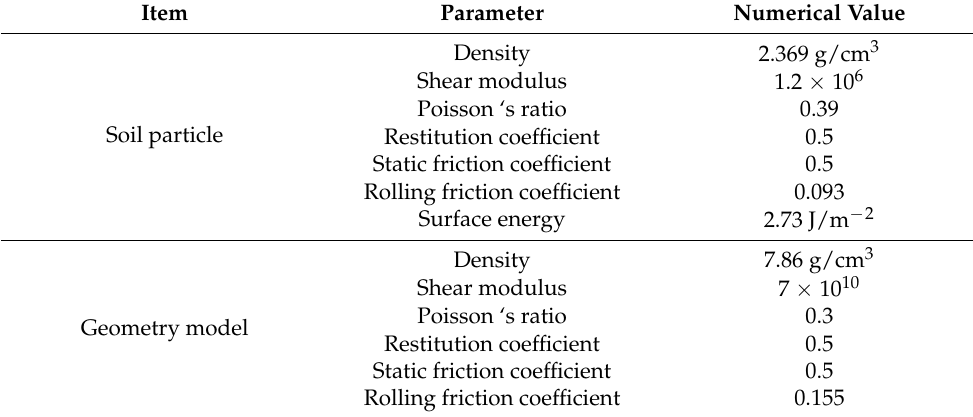
Table 1. Contact parameters of simulation